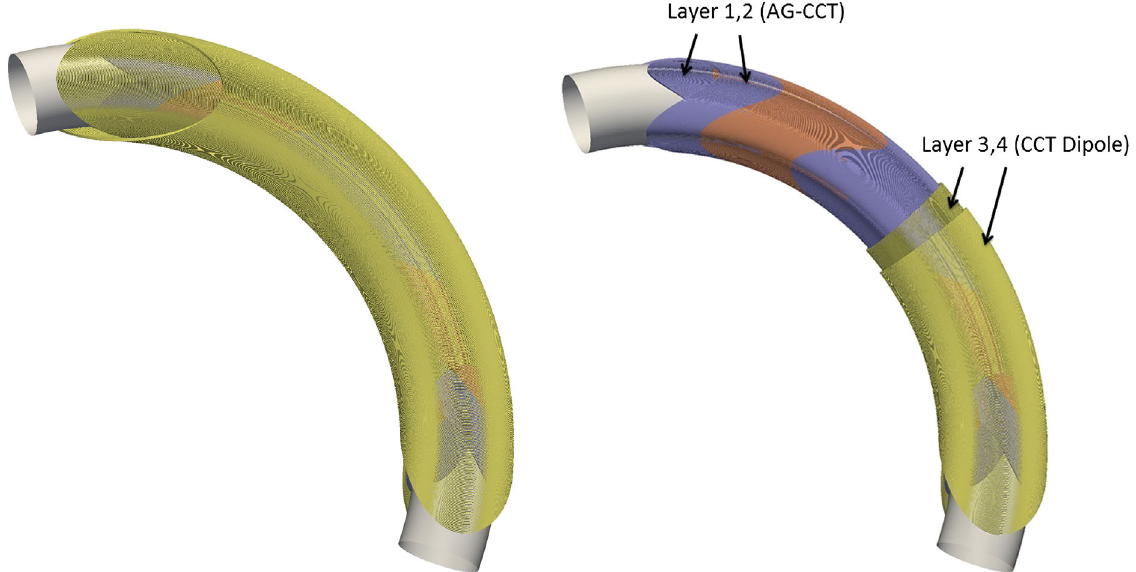
FIG. 2. Coil layers of curved 90° AG-CCT (FDFDF) magnet. Left: The four layers of coils all overlayed. Right: Only about half of two outer dipole layers (Layer 3 and 4) are shown in order to see the two inner alternating quadrupole layers (Layer 1 and